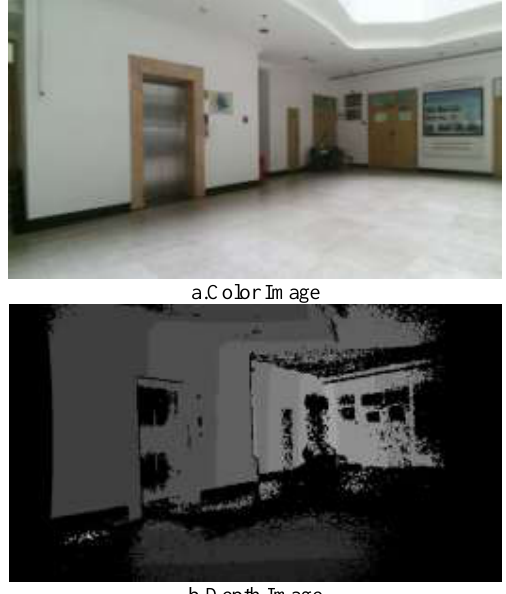
Figure 4. Frame of image data obtained by Kinect